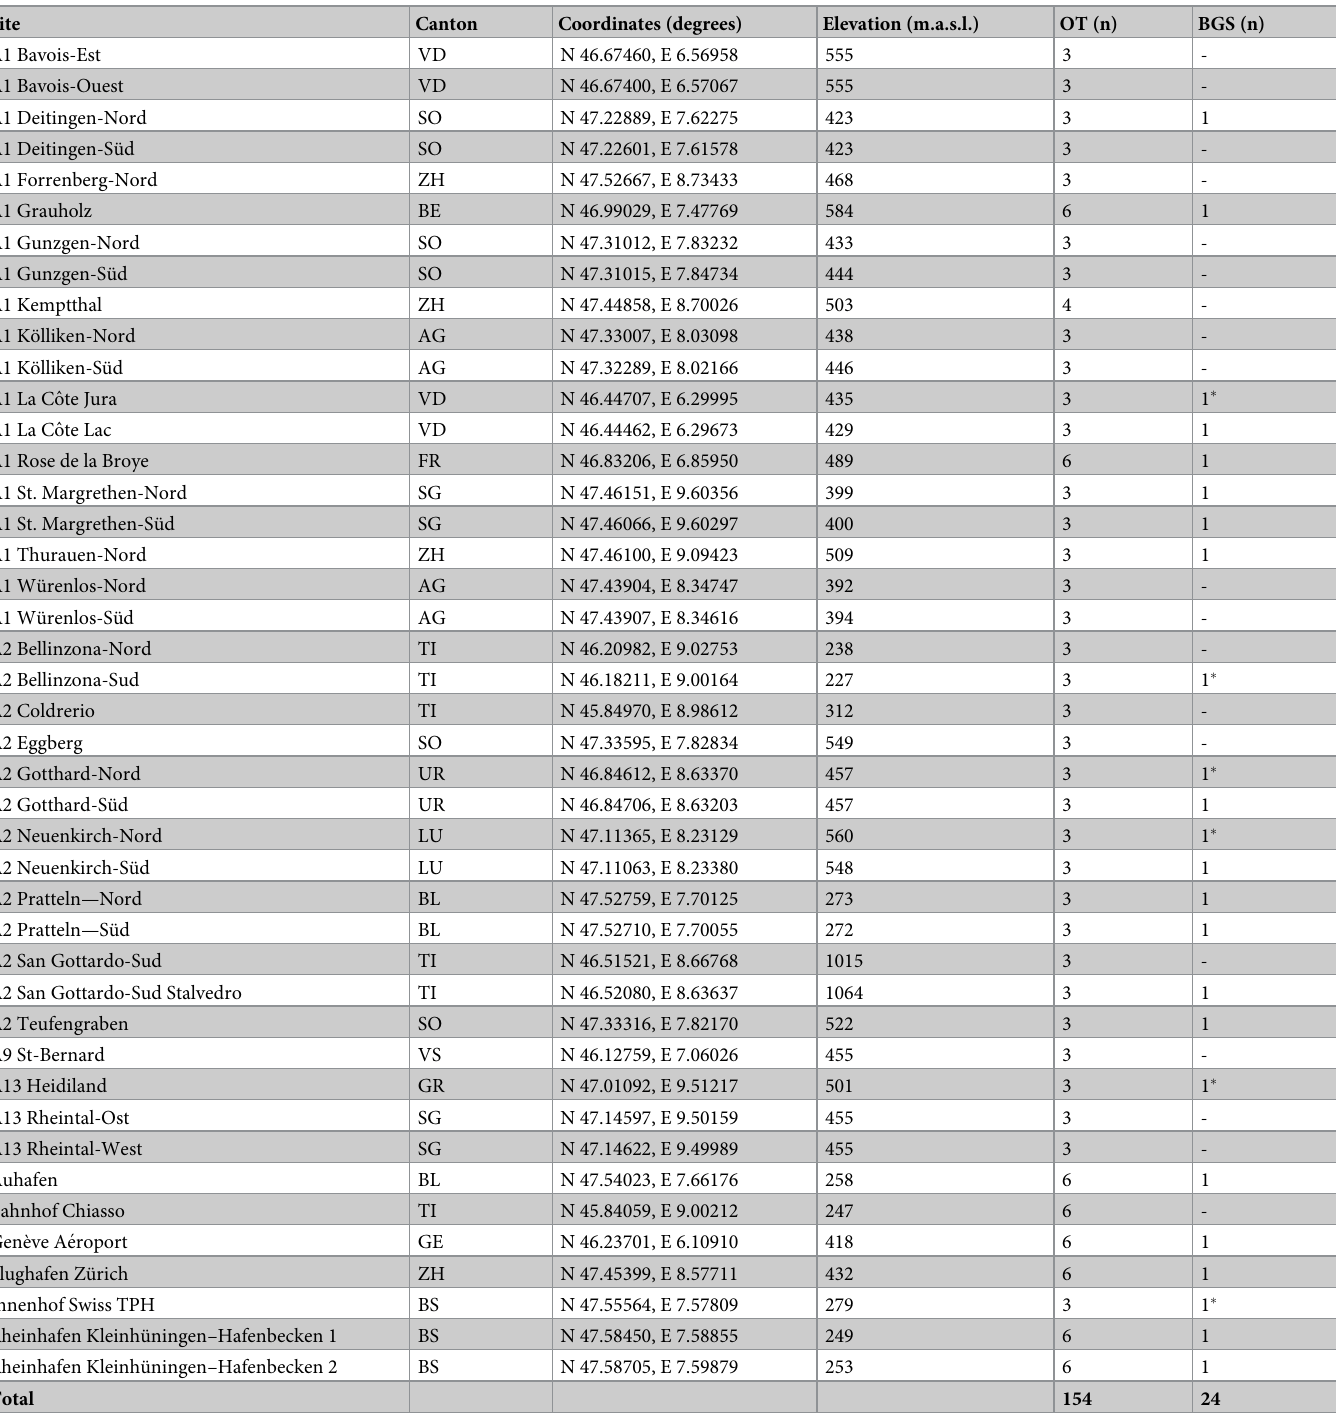
Table 1. Sampling sites and number of ovitraps and BG-Sentinel traps per site.